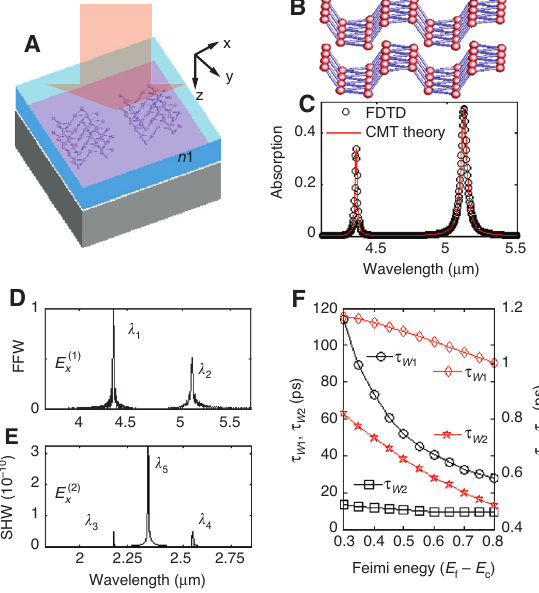
Figure 6: Absorption, FFW, SHW and lifetime of FFW in nanostructured BP. (A) The nanostructured BP nanoflake on SiO substrate. (B) The atomic 2 arrangement of the BP structure. (C) The linear-optical absorption with FDTD simulation (black circles) and the theoretical CMT (red line). (D) (1) with two wavelengths The amplitude of Fourier spectrum for FFW E x (2) with the peaks λ and λ . (E) Amplitude of Fourier spectrum for SHW E 1 2 x three wavelengths peaks λ , λ , and λ . (F) Lifetime τ , τ , τ , and τ as 3 4 5 w 1 w 2 i 1 i 2 a function of various relative Fermi energies ( E – E f c